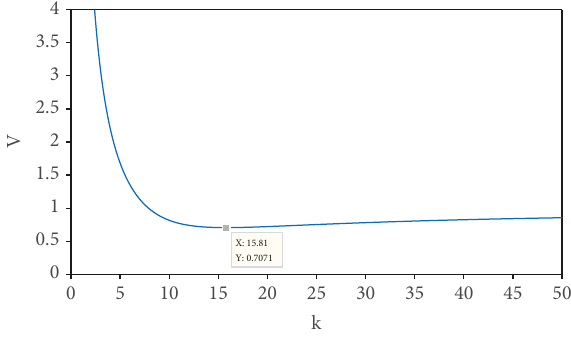
β ∗ , ∗ , k and k under